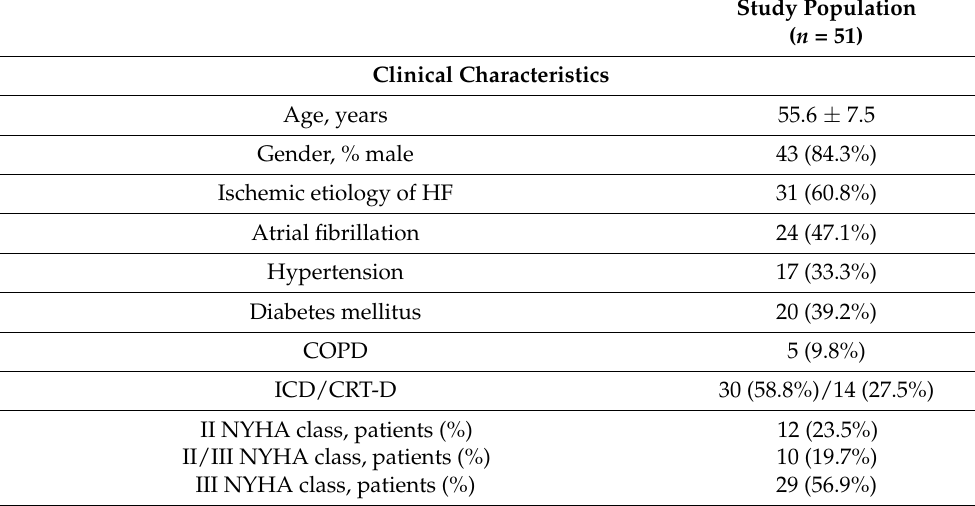
Table 1. Clinical characteristics of the study population. ACEI = angiotensin-converting enzyme inhibitor, ARB = angiotensin receptor blocker, ARNI = angiotensin receptor–neprylisin inhibitor, COPD = chronic obstructive pulmonary disease, CRT-D = cardiac resynchronization therapy defibril- lator, eGFR = estimated glomerular filtration rate, HF = heart failure, ICD = implantable cardioverter defibrillator, LVEDD = left ventricular end-diastolic dimension, LVEF = left ventricular ejection fraction, NYHA = New York Heart Association, MRA = mineralocorticoid receptor antagonist, NT-pro-BNP = N-terminal prohormone of brain natriuretic peptide, pVO2 = peak oxygen uptake, RER = respiratory exchange ratio, TAPSE = tricuspid annular plane systolic excursion, VE/VCO 2 = minute ventilation/carbon dioxide production * mitral or tricuspidal regurgitation at least